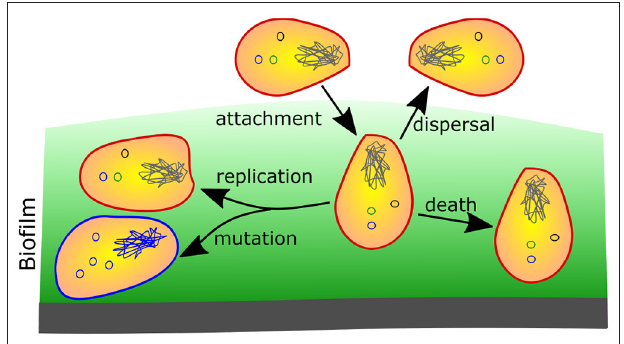
FIGURE 2 | The main population dynamic processes in a biofilm that are used for the modeling. Bacterial cells die and replicate. During replication, they can mutate. Furthermore, planktonic cells can attach to biofilm, while biofilm cells can disperse and become free-living